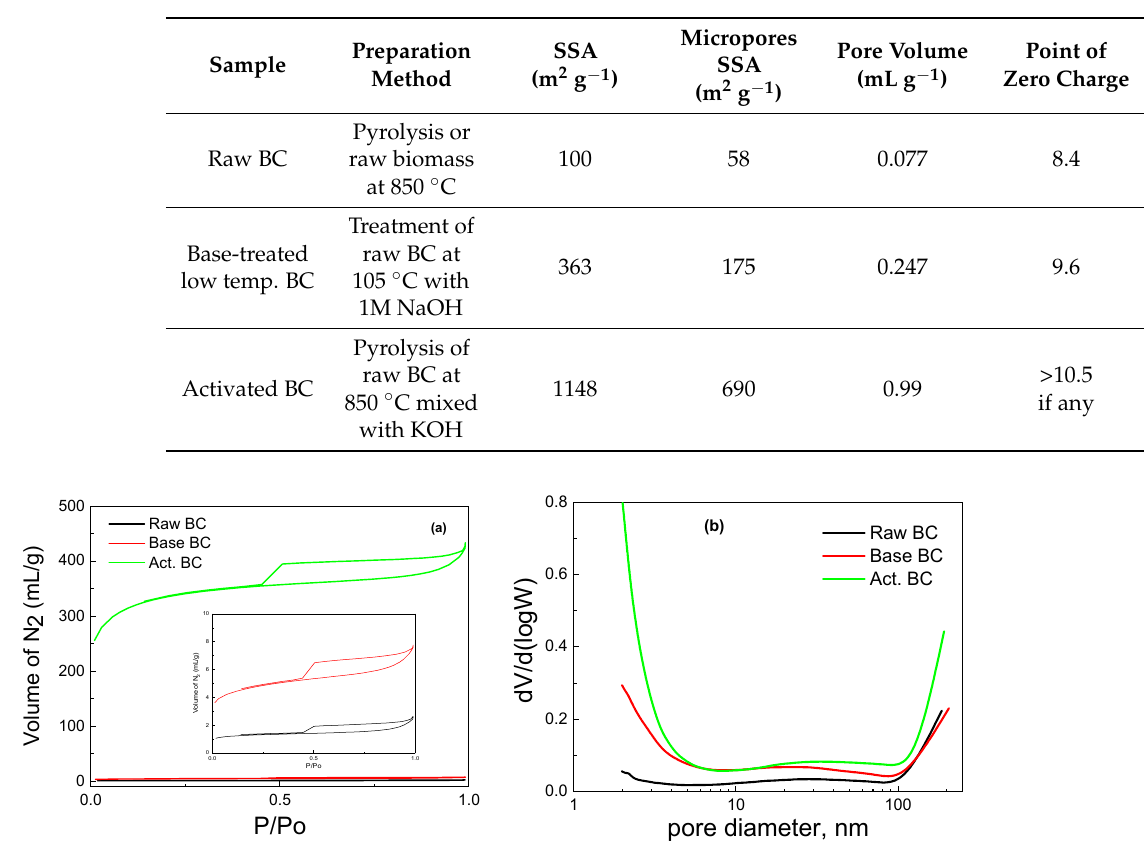
Figure 2. Adsorption-desorption isotherms ( a ) and Pore size distribution ( b ) for the studied biochars.